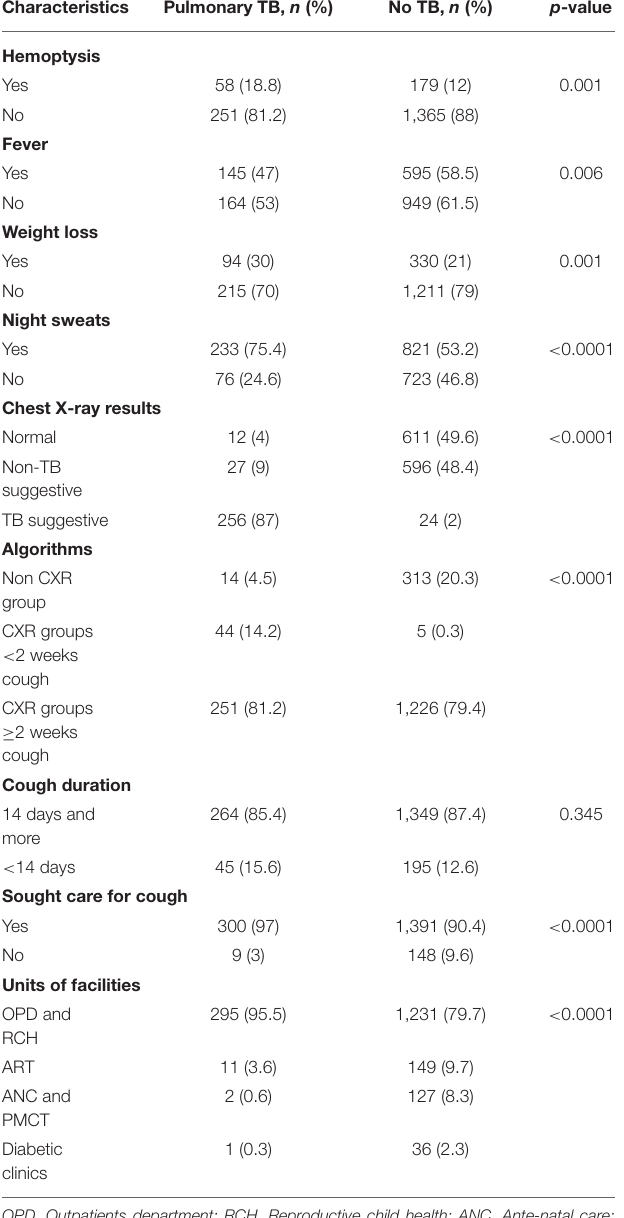
TABLE 2 | Association between clinical symptoms, chest X-ray results, others, and pulmonary TB at health facilities, Ethiopia. Characteristics